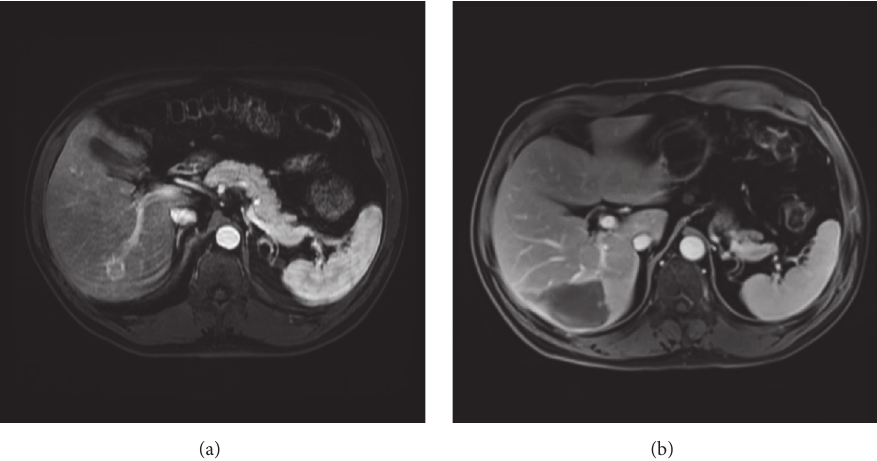
Figure 2: Abdominal MRI before microwave ablation shows a rounded lesion in liver segment 6, measuring 2.1 × 2.1cm, which demonstrates T2 hyperintensity with heterogeneous internal enhancement or restricted diffusion on MRI (a). 2 months after microwave ablation of the liver, there is evidence of postoperative and postmicrowave changes in the liver, with no suspicious enhancement in the ablation bed to suggest definite residual or recurrent tumor, and no new focal liver lesions